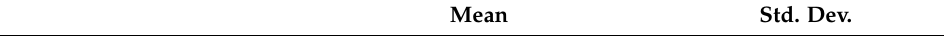
Table 4. Information and attitudes on vaccination.